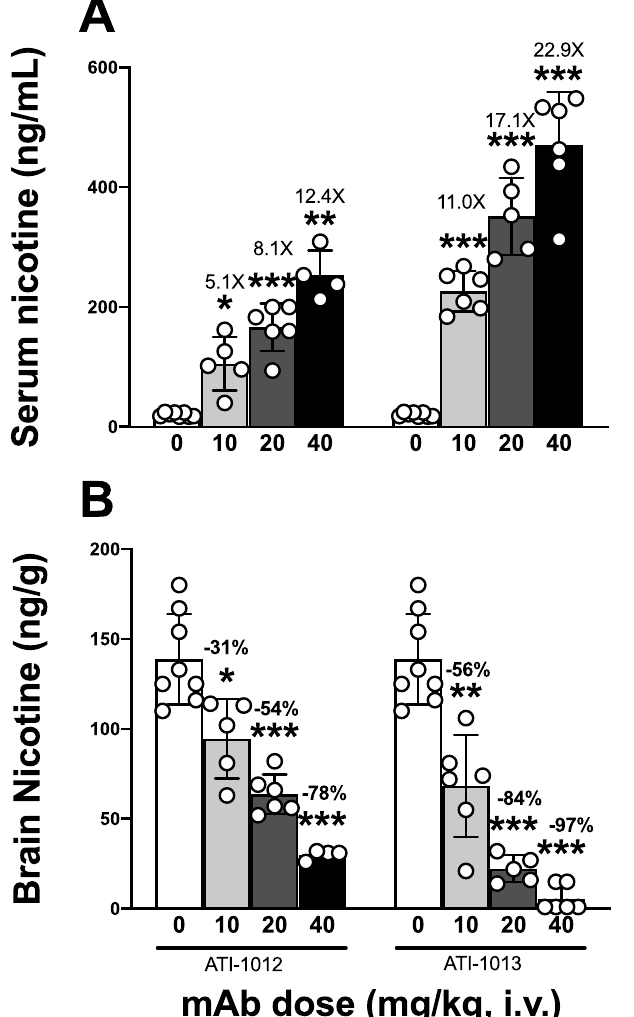
Fig 3. Single dose nicotine pharmacokinetics in rats pre-treated with ATI-1012 or ATI-1013. Doses of 10, 20, and 40 mg/kg ATI-1012, ATI-1013 and control (0 mg/kg) were given to rats (n = 8/group), followed by administration of 0.03 mg/kg nicotine i.v. in < 10 s. Animals were sacrificed after 3 min and nicotine was measured in serum (Panel A) and brain (Panel B). Numbers above the bars indicate fold increase in serum nicotine or the percentage remaining in brain. Due to patency issues, some animals did not receive adequate nic•mAb (refer to the Methods section for more details). � p < 0.05, �� p < 0.01, ��� p < 0.001 significantly different compared to controls. Data are expressed as mean ±